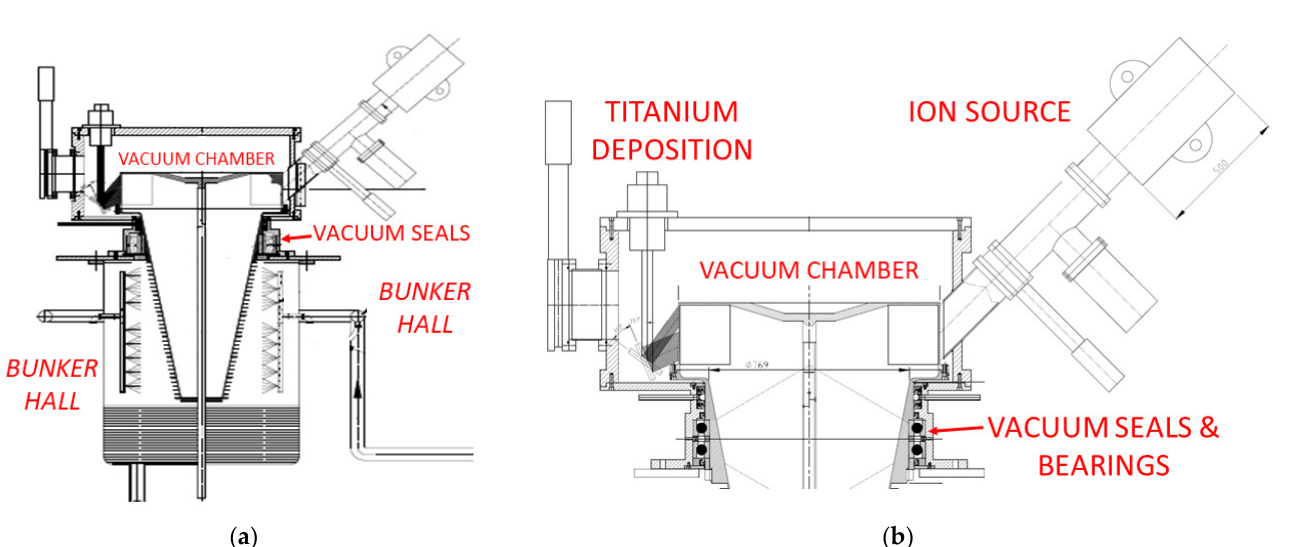
Figure 2. Preliminary design of the rotating target for the Sorgentina-RF project ( a ), and blowout of the ferrofluidic seals ( b ). Table 1. FMEA of the seals for the vacuum inside the VC.